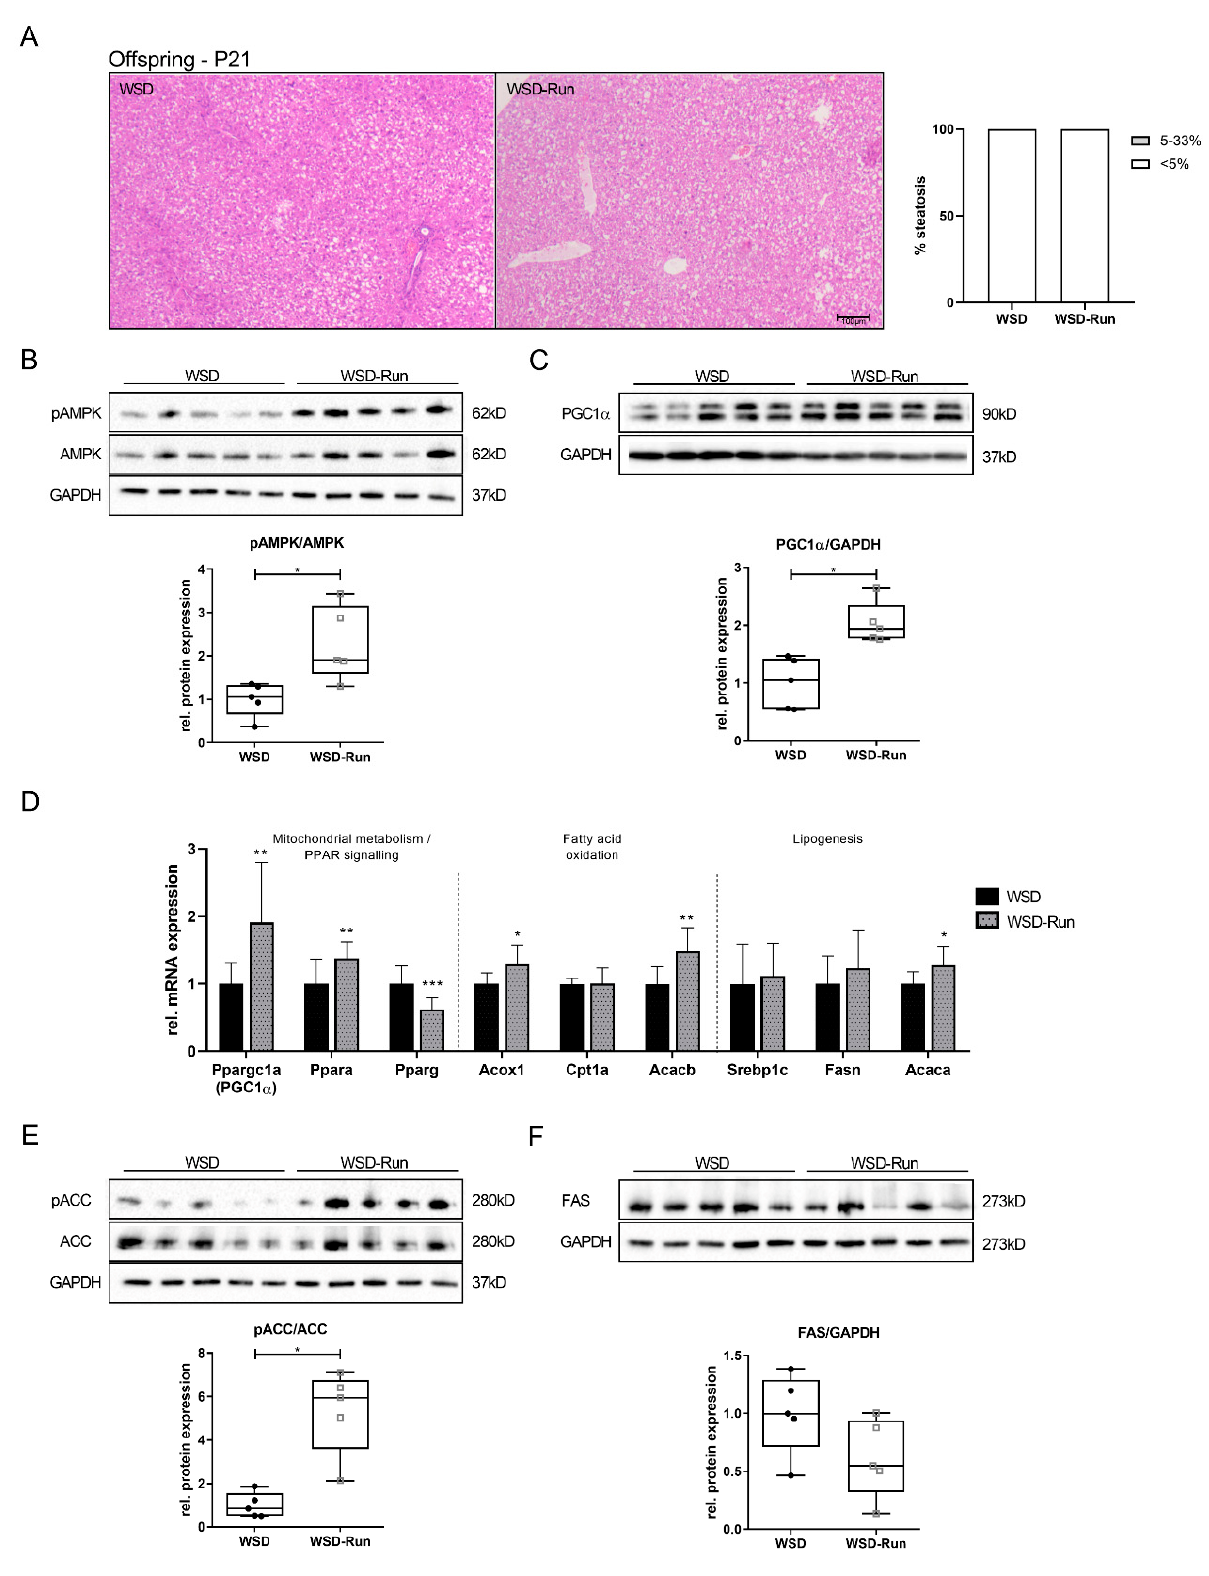
Figure 5. Maternal exercise before and during pregnancy alters offspring hepatic AMPK-PGC1 α axis in early life (P21). ( A ) Histological analysis of amount of hepatic steatosis in offspring at the end of lactation (P21) by H&E staining revealed no significant hepatic steatosis in offspring of both groups in early life. Magnification: 20 × . Percentage of steatosis, scored as 0 (< 5%) percentage of hepatocytes containing lipid droplets (WSD group (n = 19), WSD-Run group (n = 12)). ( B , C ) Assessment of key hepatic energy regulators using immunoblots revealed an expression profile comparable to that ob- served in the dams. ( B ) pAMPK/AMPK protein expression. ( C ) PGC1 α protein expression. ( D ) Assessment of regulators of hepatic mitochondrial metabolism ( Ppargc1a (Pgc1 α ), Ppara , Pparg ), hepatic fatty acid oxidation ( Acox1 , Cpt1a , Acacb ),